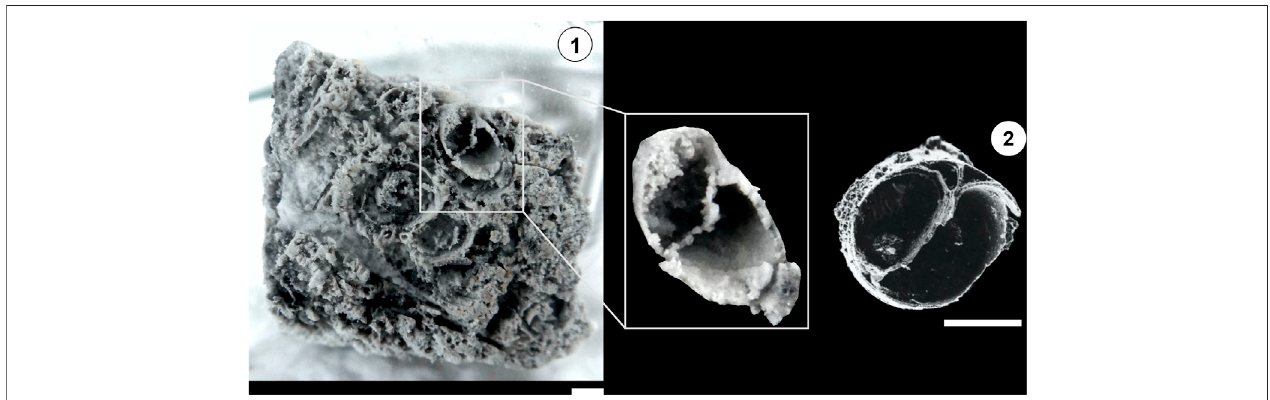
FIGURE 10 | Comparison between results of different preparations. (1) Cloudina lucianoi (Beurlen and Sommer, 1957), CP974. Sample MP2289, carbonate from the type-section of Cloudina riemkeae Germs, 1972, Nomtsas Formation, Namibia, (UTM Coord. 33 k 0667883 7358829); (2) Phosphatized skeleton of Cloudina lucianoi from Dengying Formation, China (Hua et al., 2005). Scale bars: 400 µm.